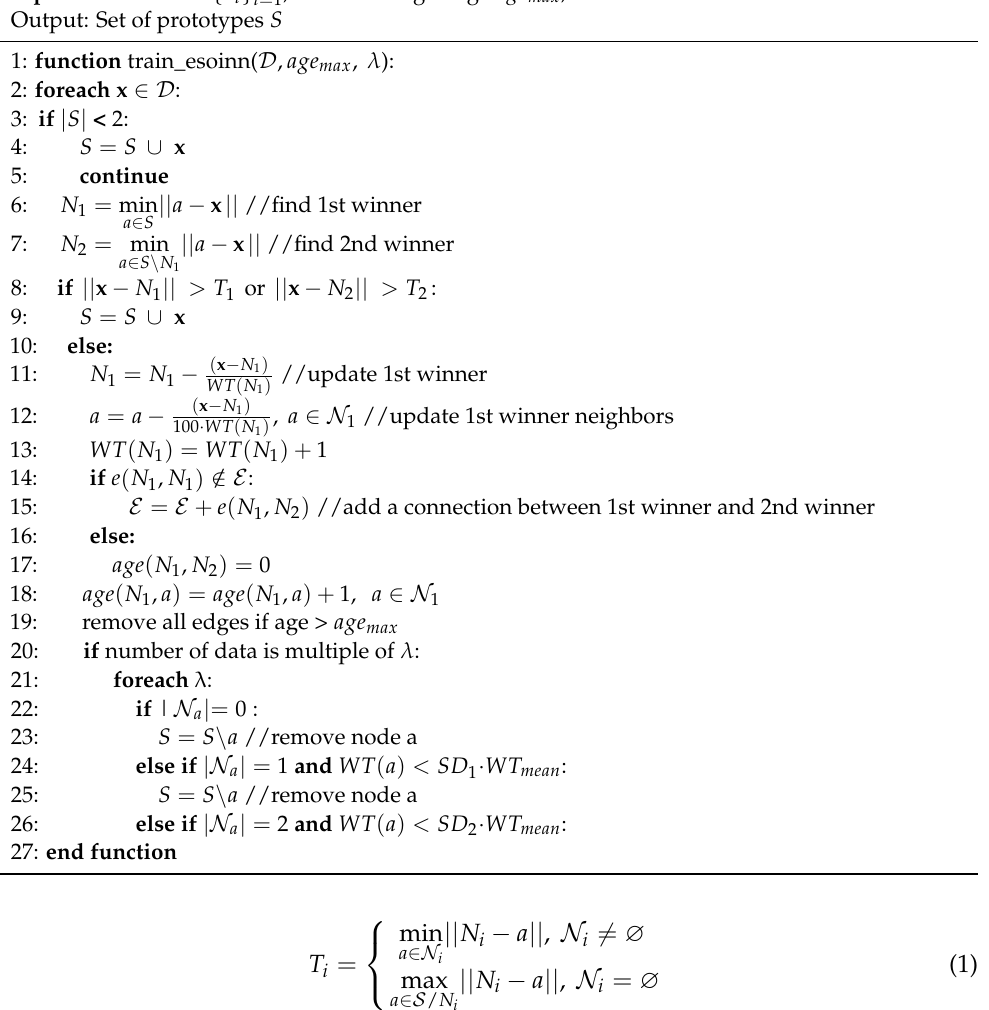
Algorithm 1: Enhanced Self-Organizing Incremental Neural Network